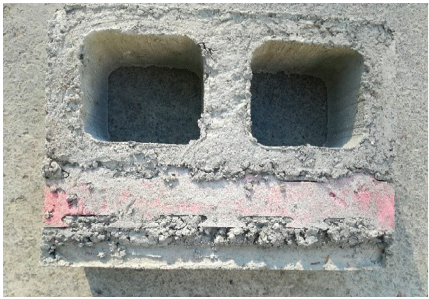
Figure 7: Upper hydraulic jack being lifted to release the block.